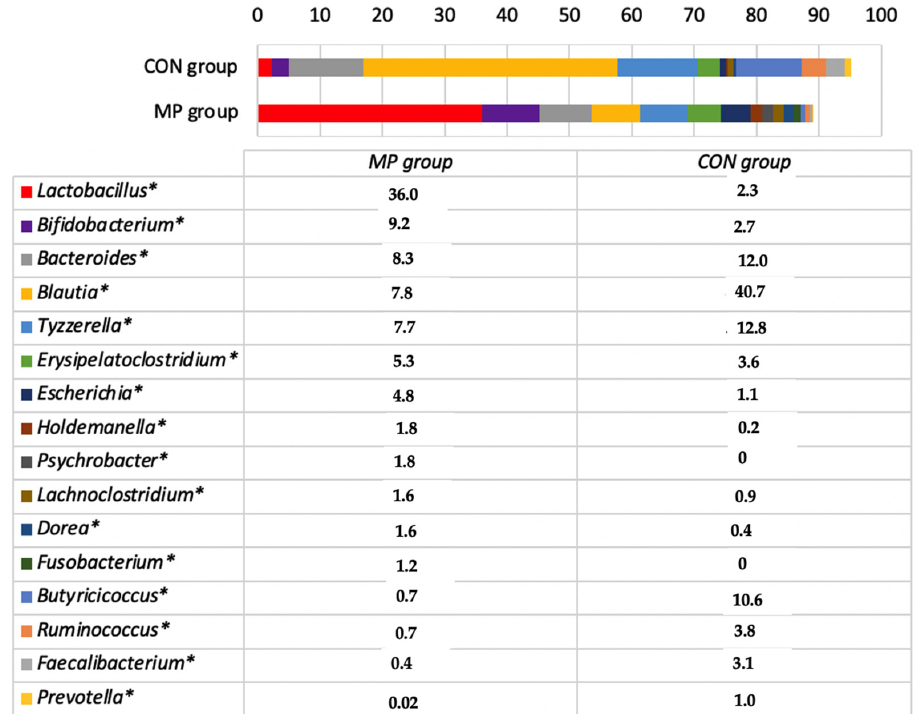
Figure 2. Bacterial genera percentage prevalence in the faeces of calves after the experiment. The genera are included in the list only if the prevalence was at least 1% of the total bacterial reads in the faeces of both groups. CON, calves fed with milk replacer only; MP, calves fed with milk replacer and supplemented with fermented milk permeate.* Significant dif- ferences between the